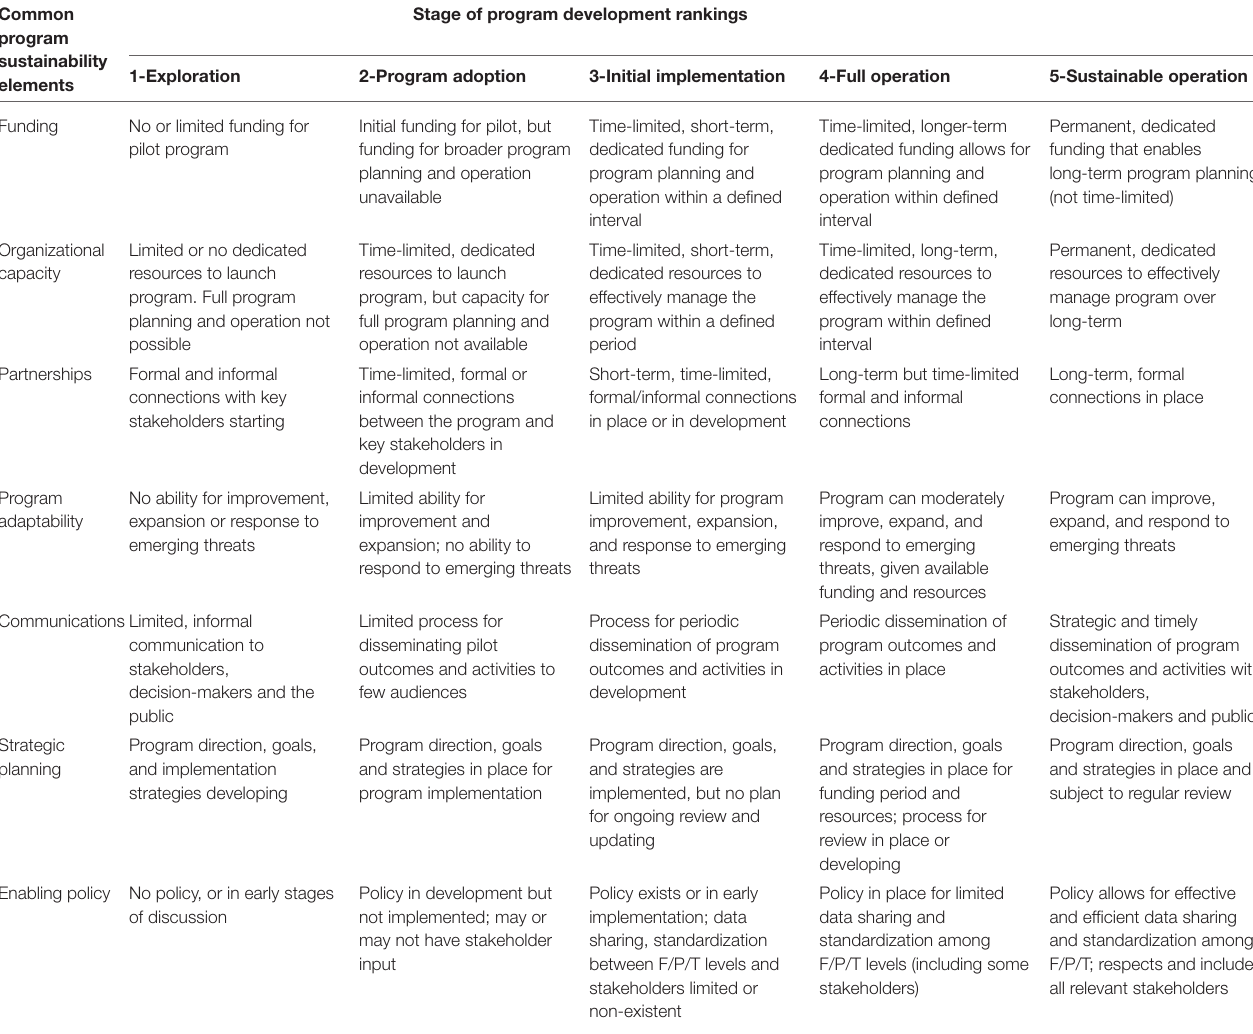
TABLE 3 | The matrix for the One Health Evaluation—Antimicrobial Use and Resistance Surveillance (OHE-AMURS) tool to evaluate national, integrated antimicrobial resistance and antimicrobial use surveillance program component elements in Canada. Common